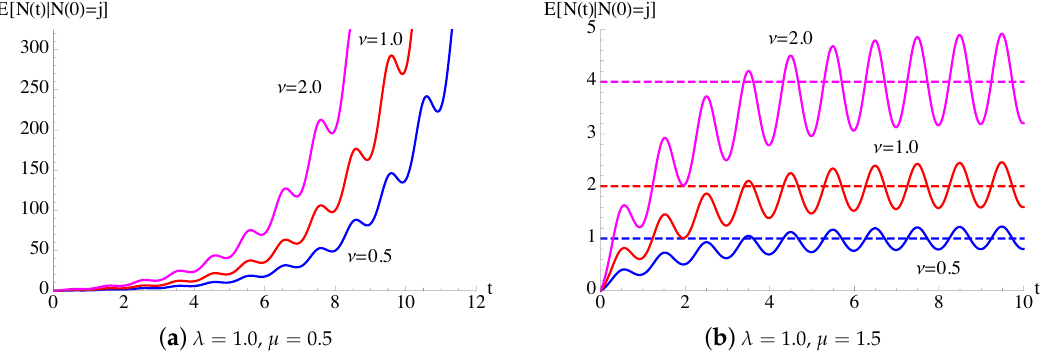
Figure 12. For the GPyD process of Figure 11, the conditional mean (61) is plotted as function of t for j = 0, a = 0.9, Q = 1.0 and for some choices of ν